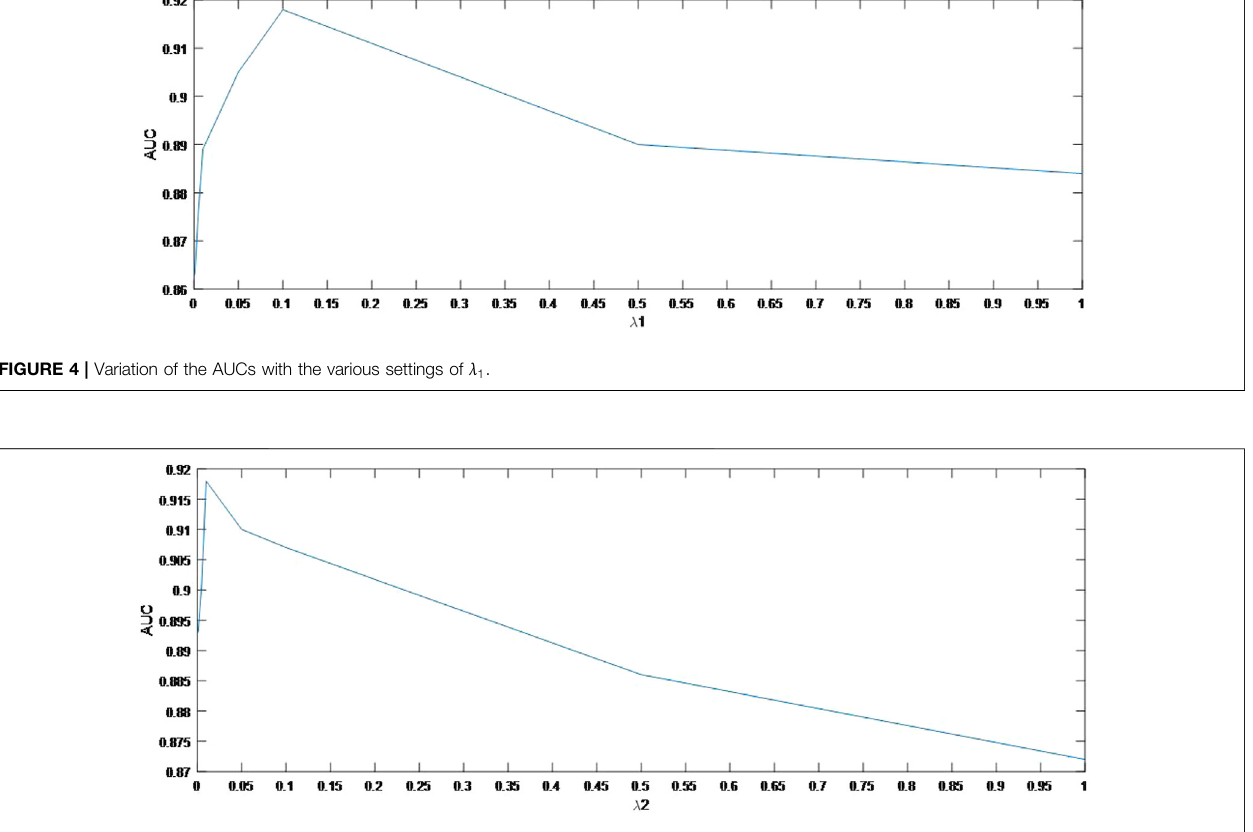
FIGURE 5 | Variation of the AUCs with the various settings of λ 2 .